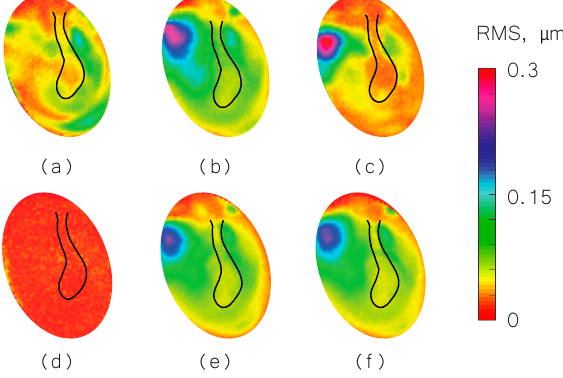
Figure 6. RMS of TB5 displacement under different conditions. ( a ) Open cavity; ( b ) closed cavity; ( c ) half fluid in contact; ( d ) full fluid in contact; ( e ) stapes immobilization; and ( f ) IS joint interruption.